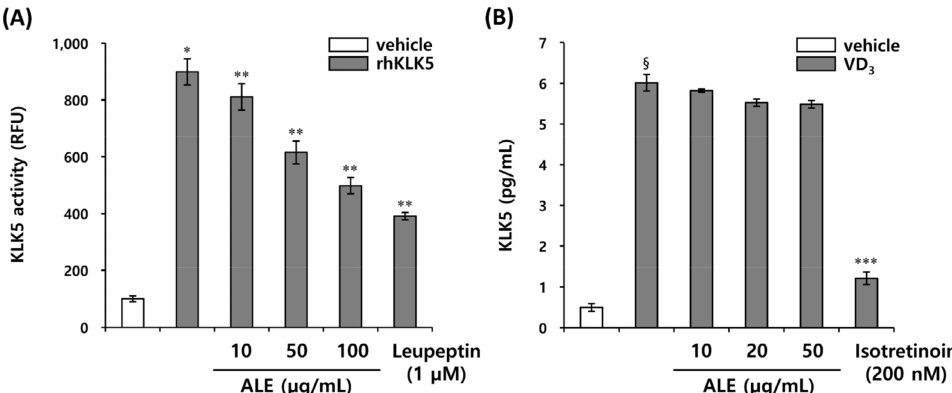
Figure 1. ALE inhibits KLK5 protease activity. ( A ) KLK5 activity was measured in relative fluo- rescence units (RFUs) using Boc-V-P-R-AMC, fluorogenic peptide substrate. ( B ) KLK5 expression was measured in HEKn induced by VD 3 . The results are expressed as mean ± standard devia- tion (SD) ( n = 3). * p < 0.01 vs. vehicle control; ** p < 0.05 vs. rhKLK5-treated control; § p < 0.01 vs. VD 3 -untreated control; *** p < 0.05 vs. VD 3 -treated